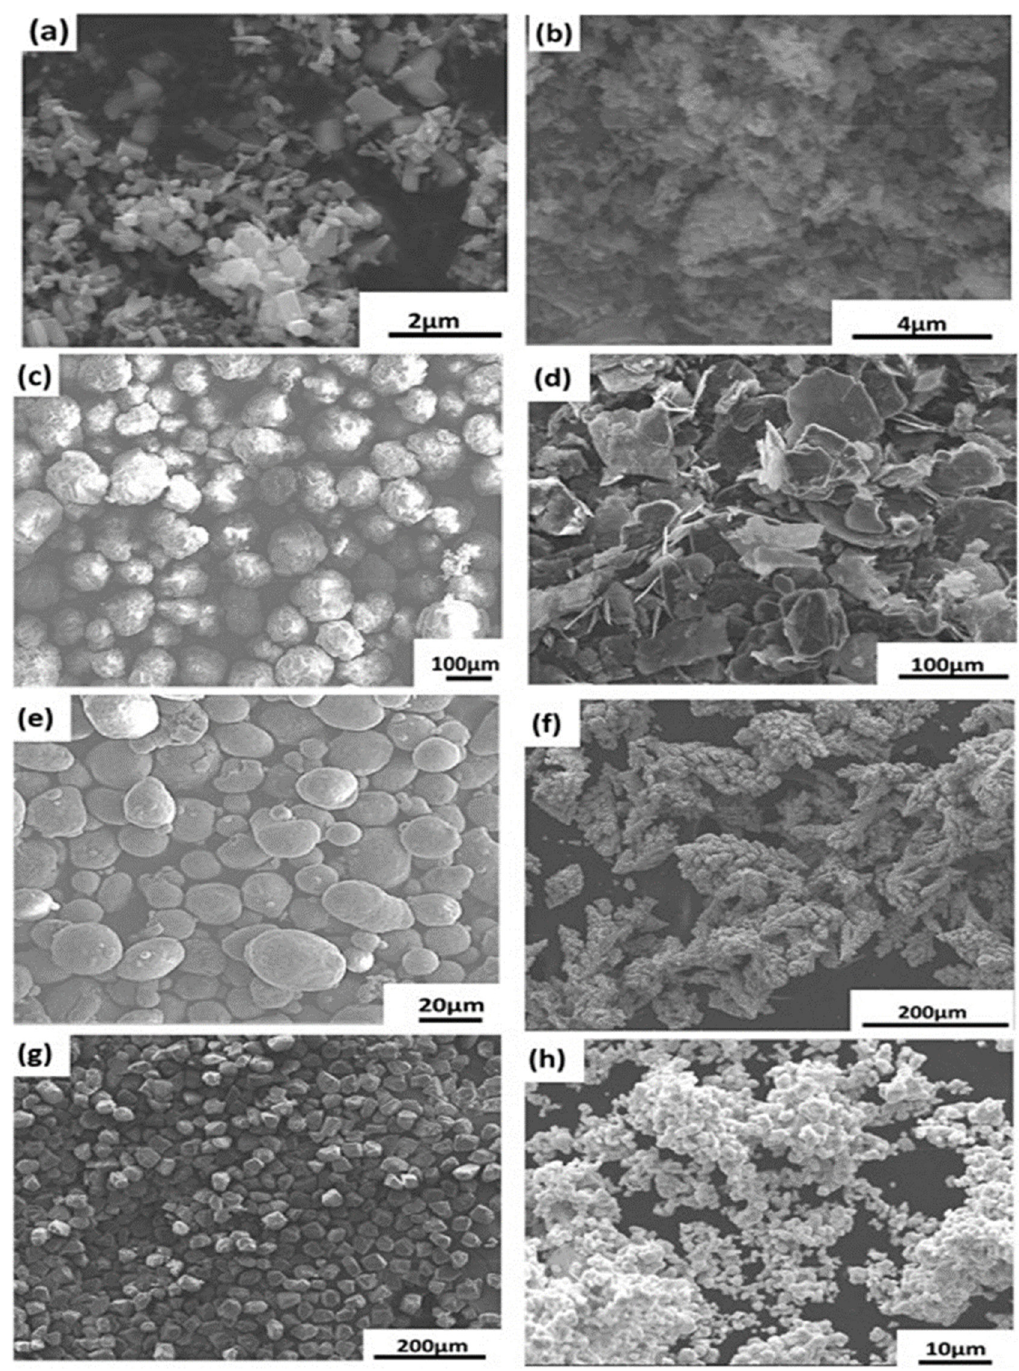
Figure 9. SEM images of fillers sample as powder form. ( a ) ZnO, ( b ) BN, ( c ) Al 2 O 3, ( d ) graphite flake, ( e ) Al ( f ) Cu ( g ) diamond and, ( h ) Ag powders [106].